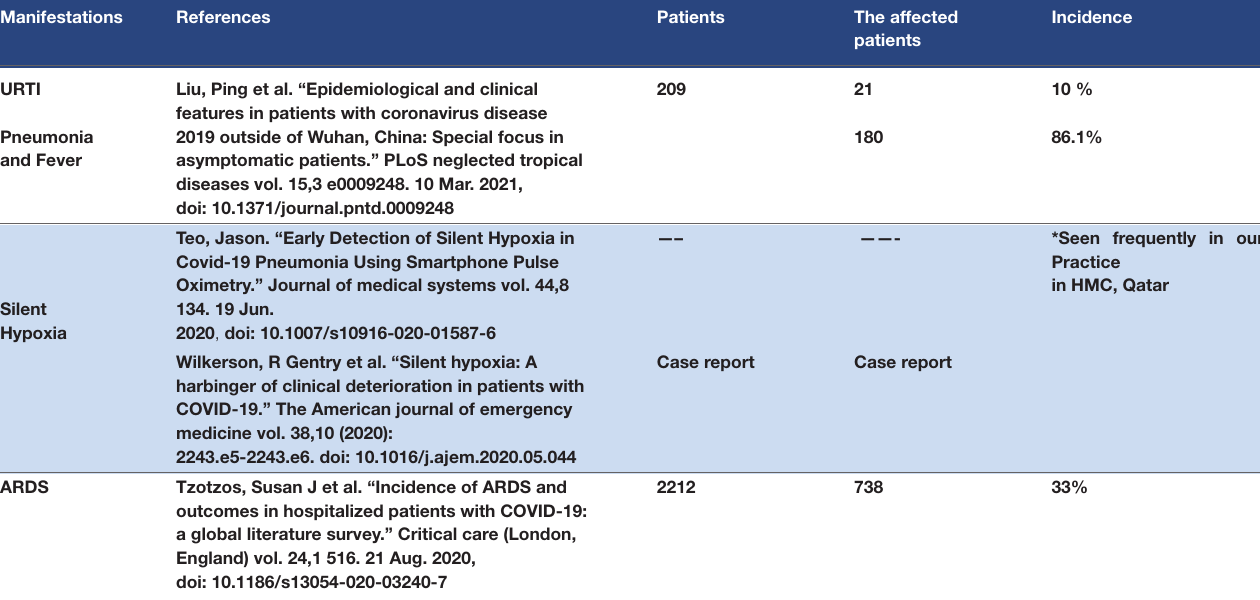
Incidence patients